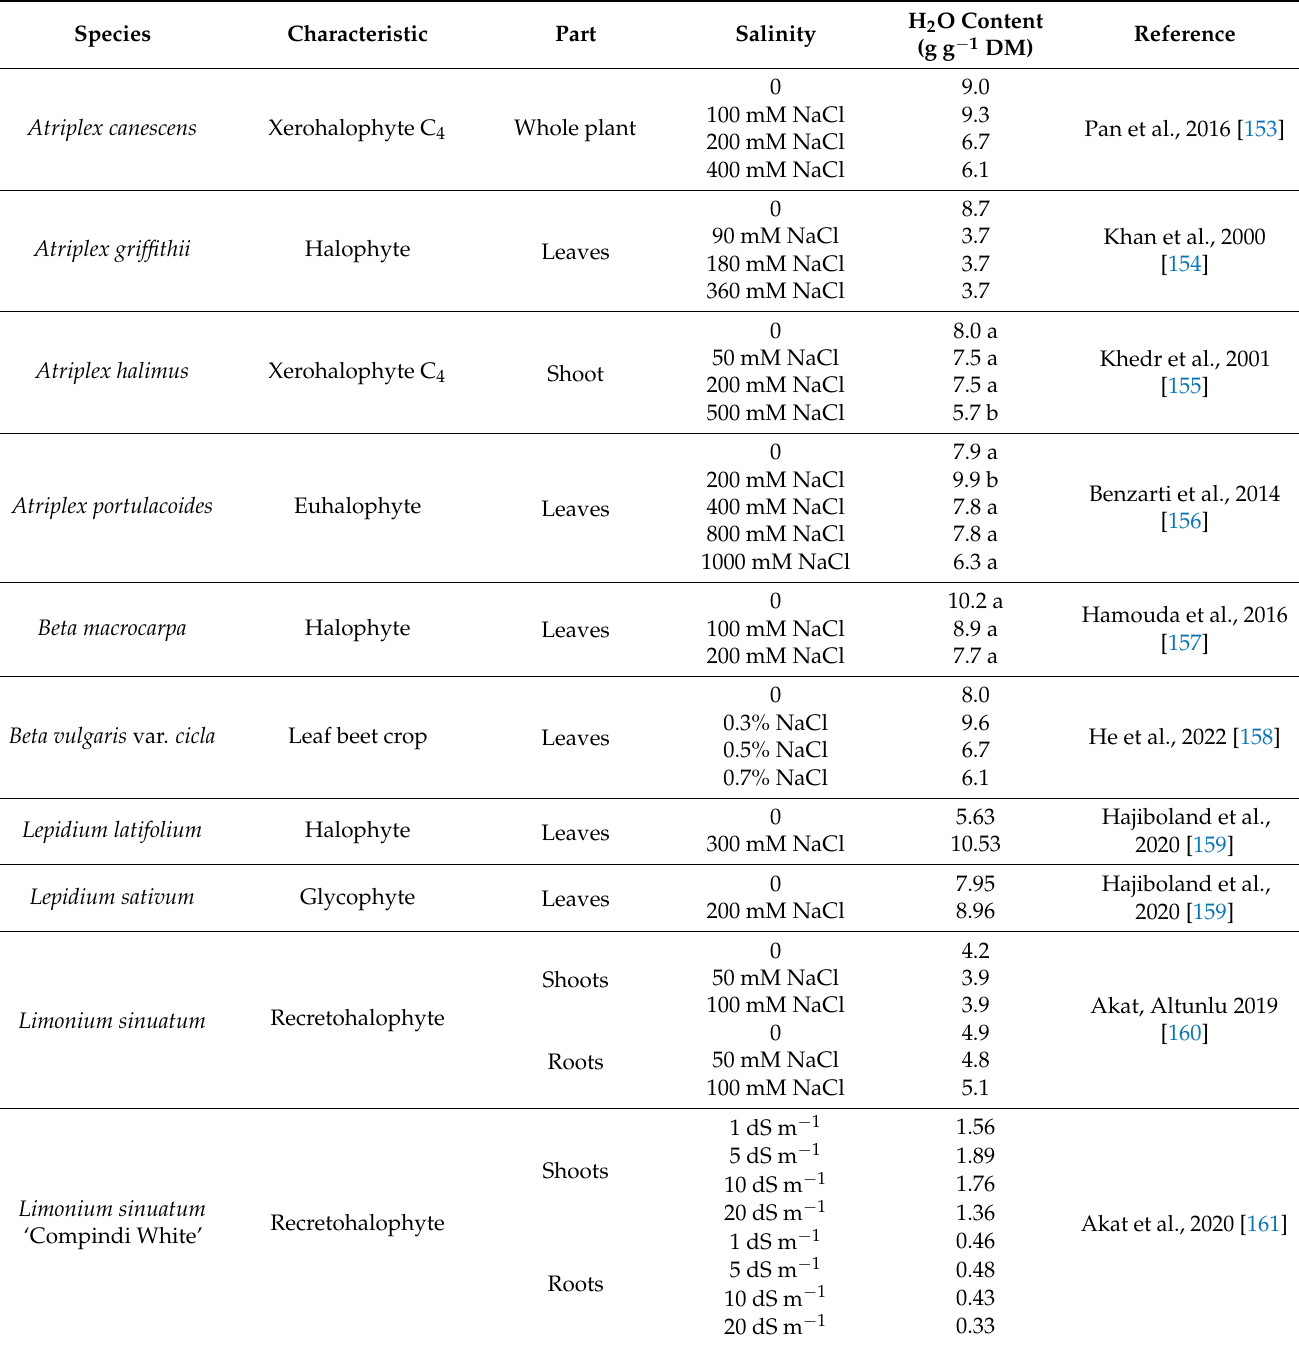
Table 5. Effect of salinity on water content of tissues in various plant